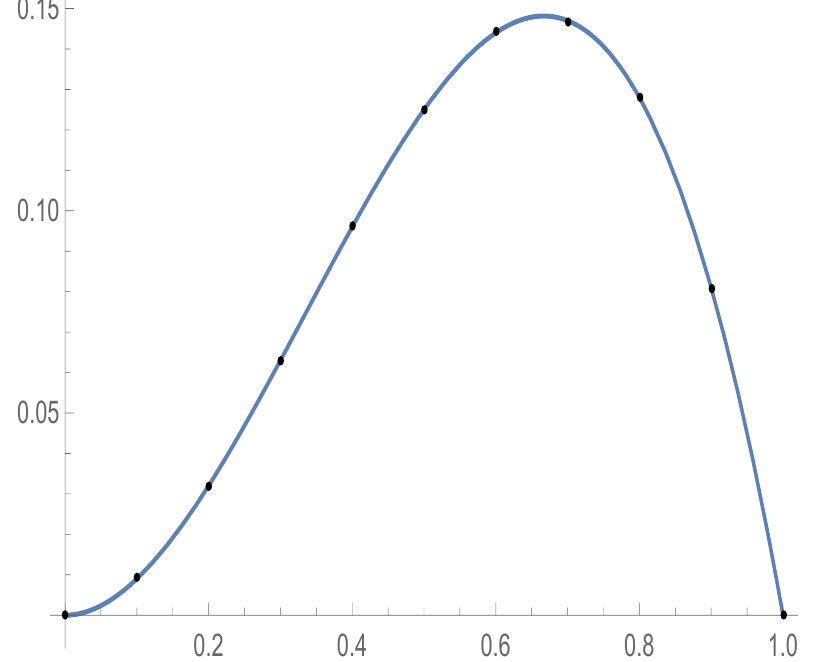
Figure 2. Exact solution and the discrete one obtained with the PHNT for h = 1